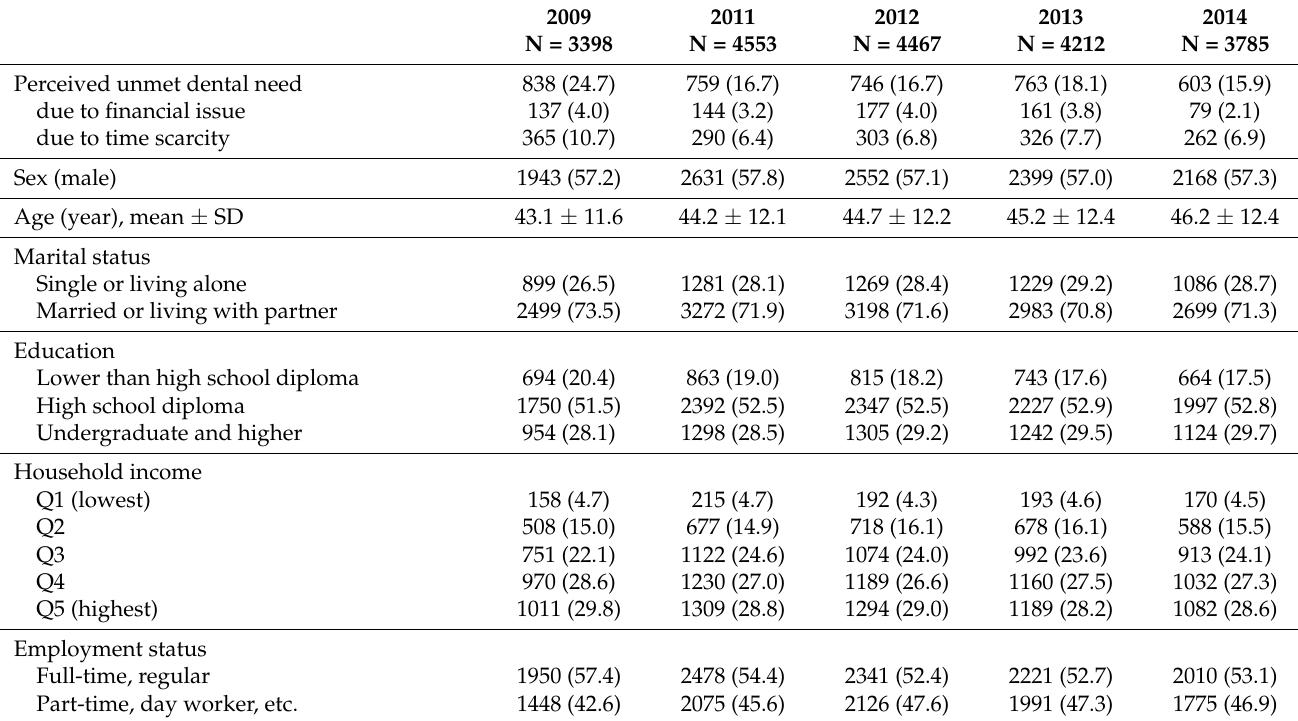
Table 1. General characteristics of the